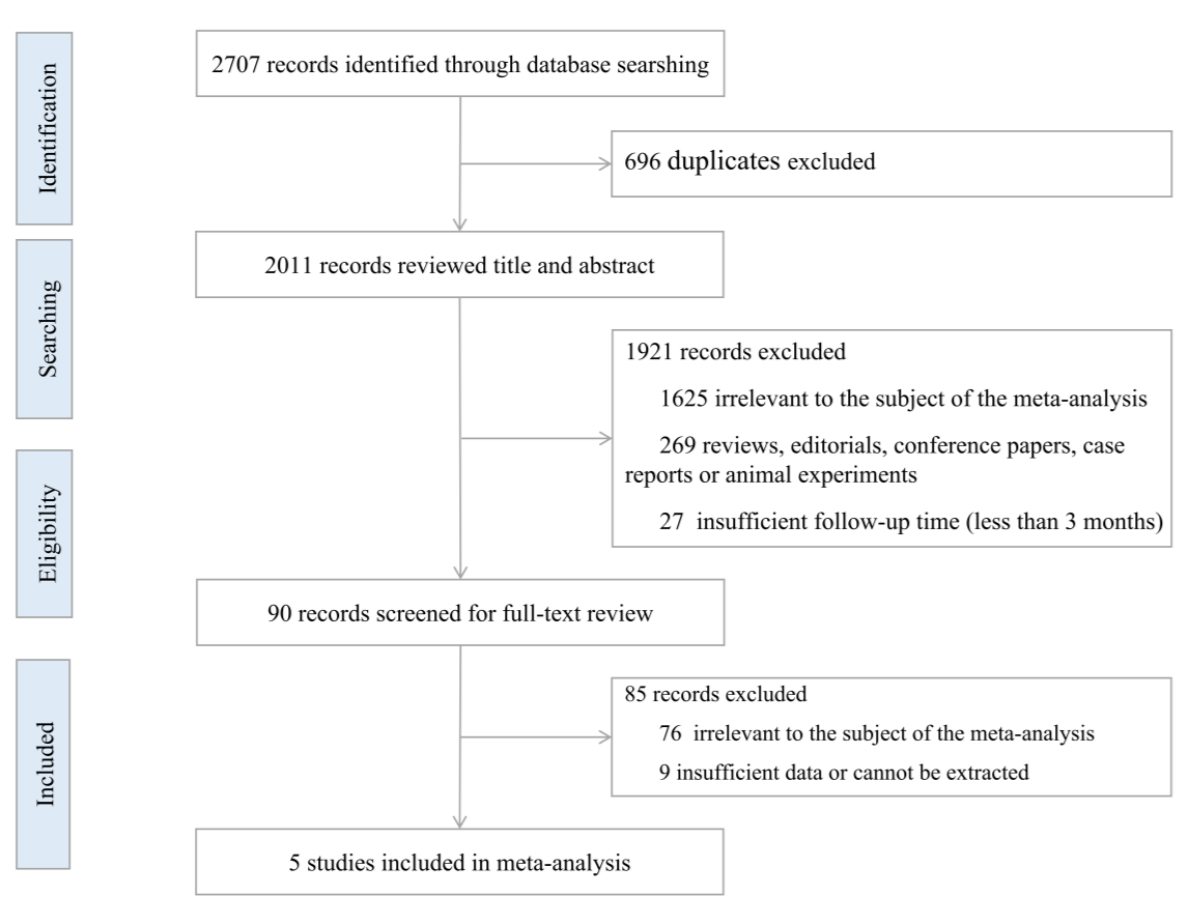
Figure 1. Flowchart of the study selection.